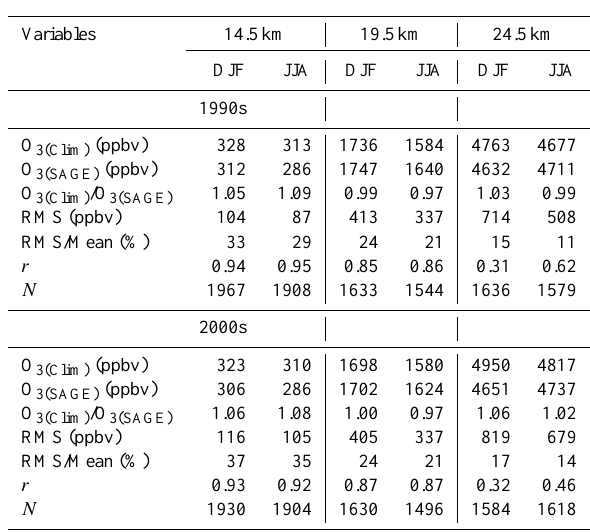
Table 3. Comparison of the ozone climatology and SAGE in the 1990s and the 2000s at three altitudes in NH winter (DJF) and summer (JJA), respectively. All the correlation coefficients ( r) are significant at a significance level <1% ( p < 0 . 01). O 3(Clim) and O 3(SAGE) are the ozone mixing ratios for the climatology and SAGE data, respectively, averaged over grid cells where both data are available (the number of grid cells is indicated as N) . The RMS is the root mean square difference between the climatology and SAGE data; and RMS/mean is the ratio of the RMS to the mean of O 3(Clim) and O 3(SAGE) .